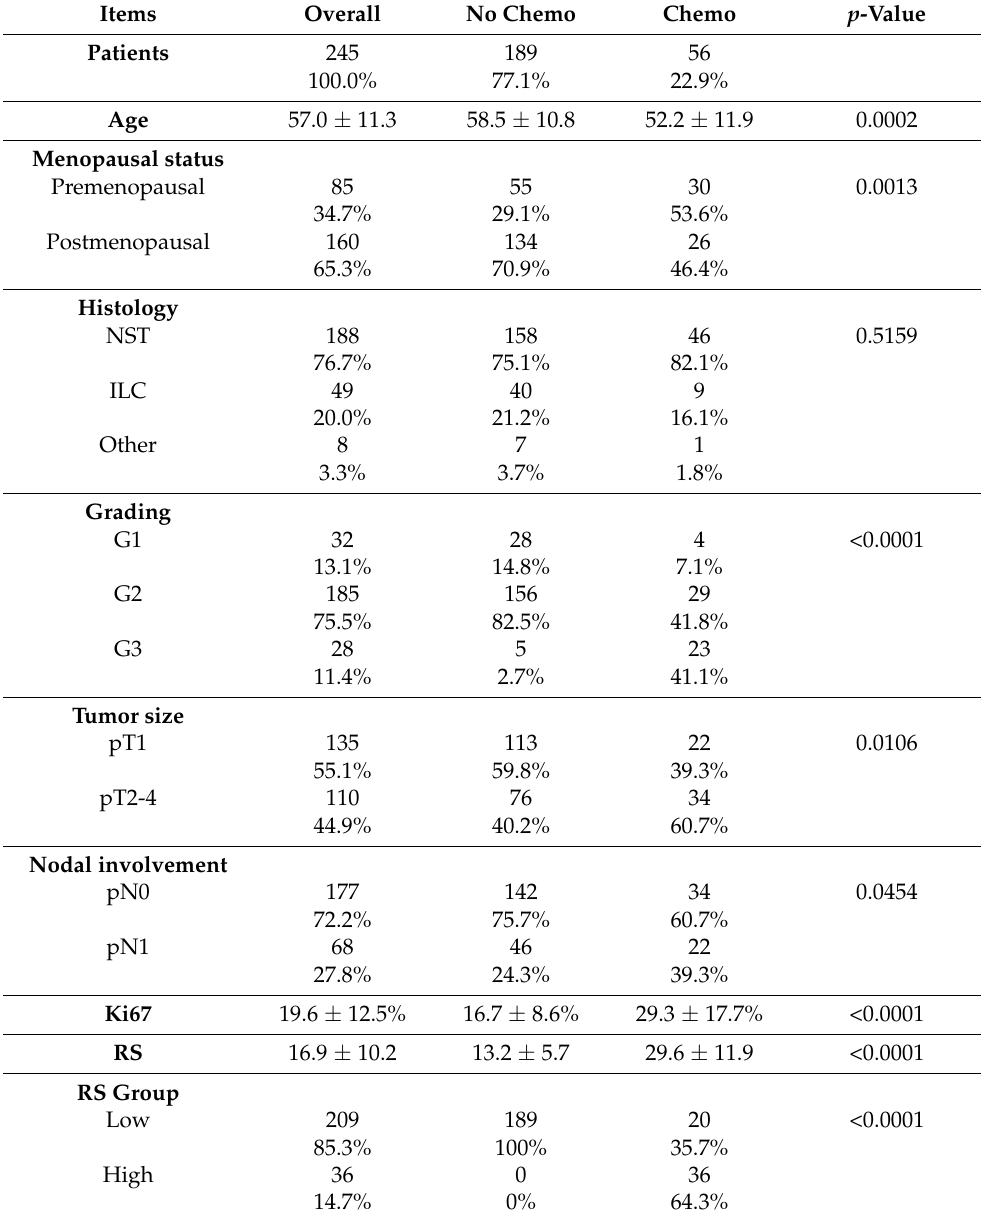
Table 2. Patient characteristics compared with chemotherapy recommendation in knowledge of Recurrence Score